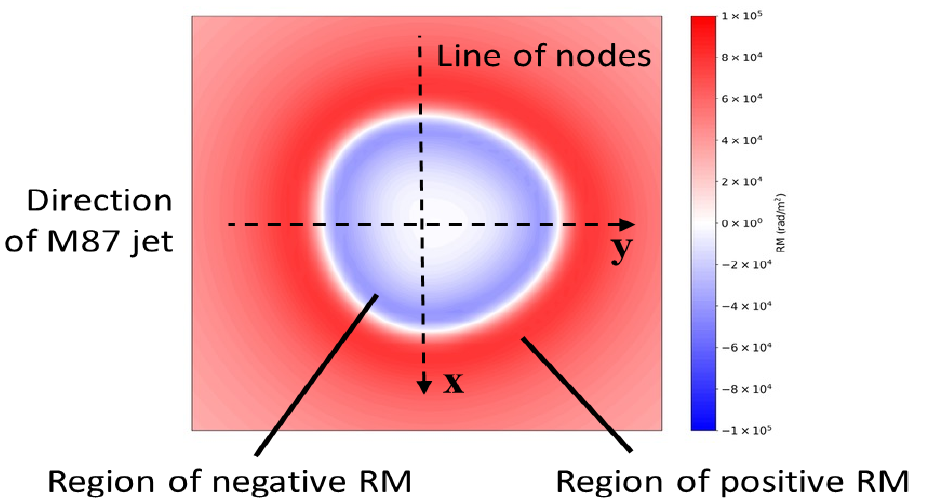
Figure 2. RM map according to the Cosmic Battery described through Equations (5)–(7). The distance of field reversal is assumed at R CB = 4.5 GM / c 2